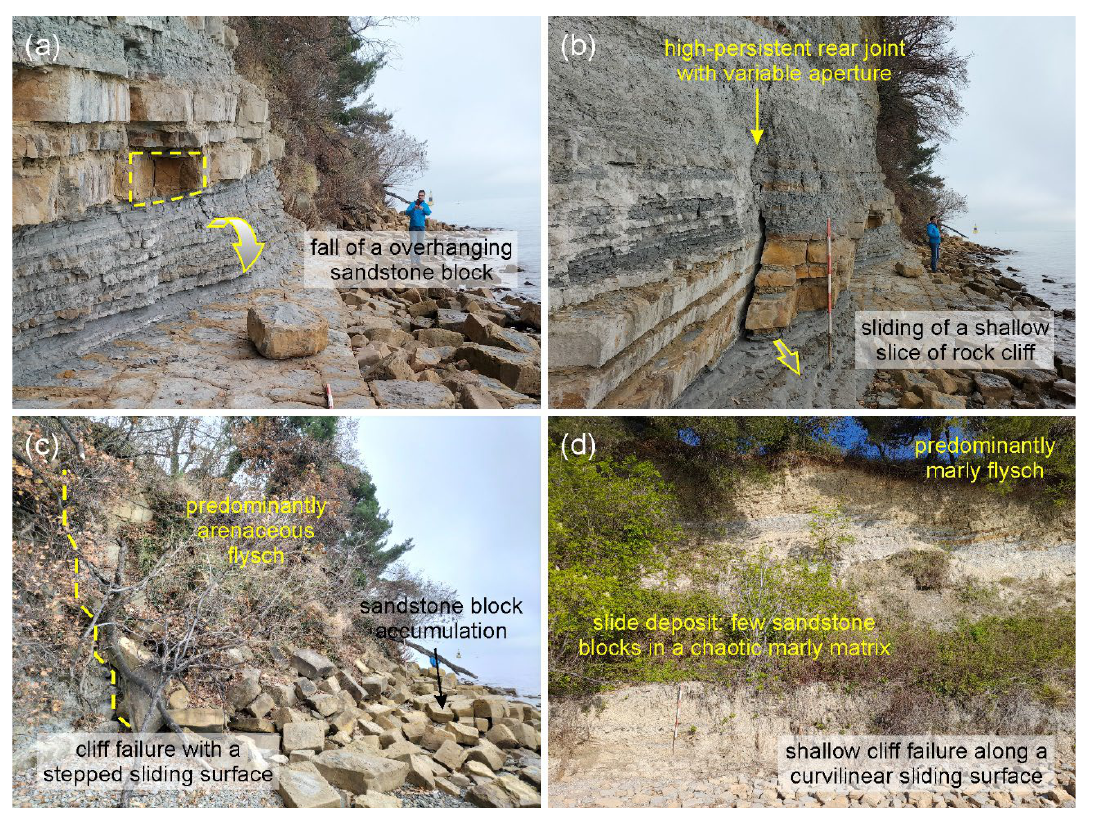
Figure 16. Slope failure types identified along the sea cliff at Debeli Rtič: ( a ) fall / toppling failure of overhanging sandstone blocks; ( b ) sliding / toppling failure of shallow stratified rock masses; ( c ) stepped sliding failure in a predominantly arenaceous Flysch; and ( d ) shallow curvilinear sliding failure in a predominantly marly Flysch.